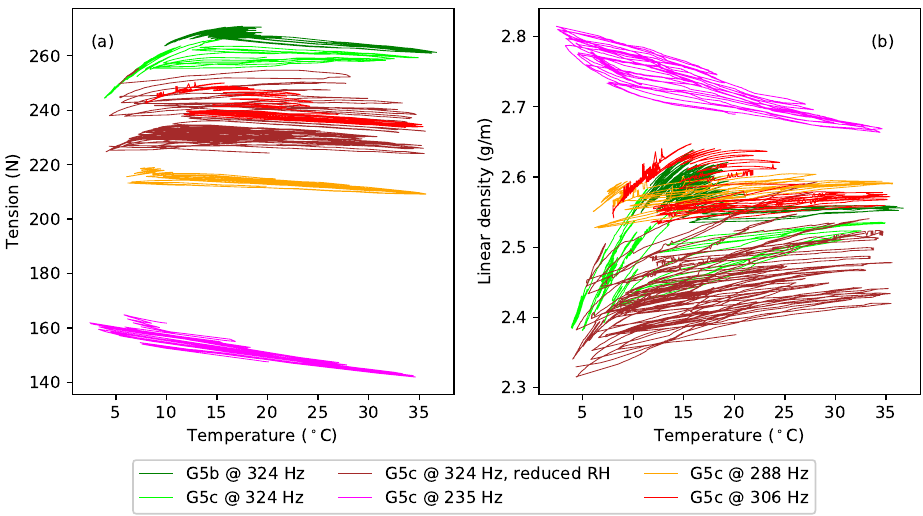
Figure 13. ( a ) Tension and ( b ) linear density versus temperature responses for strings G5b and G5c during the extended